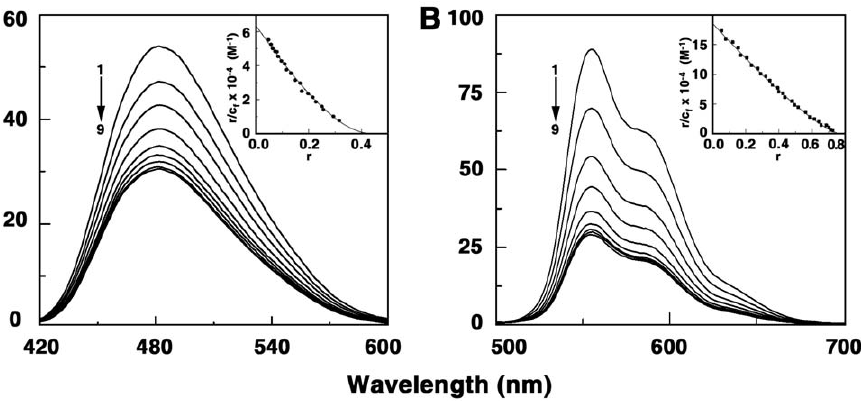
Figure 3. Fluorescence spectral titration of drugs and tRNA. (A) ADG (3.07 m M) treated with 0, 15.35, 30.7, 46.05, 61.4, 92.1, 122.8, 168.85 and 214.9 m M (curves 1–8) of tRNA and (B) DAU (3.0 m M) treated with 0, 15, 30, 45, 60, 75, 90, 105 and 120 m M (curves 1–8) of tRNA.